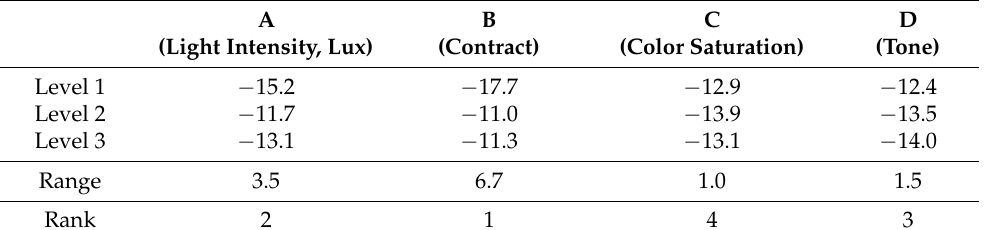
Table 2. Factor Response Analysis.